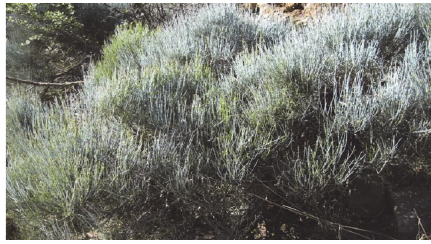
Figure 1: Ephedra intermedia